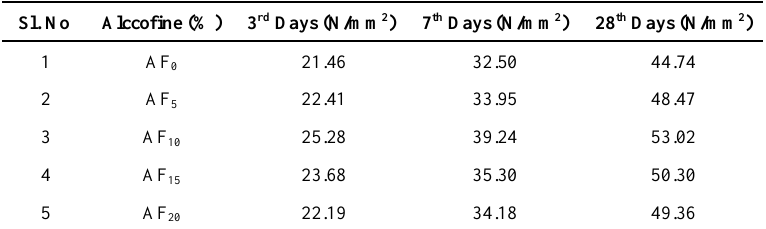
Table 8. Mortar cube compressive strength test (OPC AF